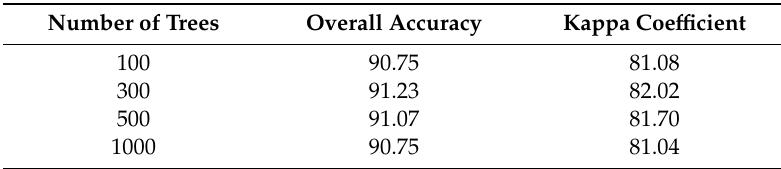
Table 2. Performance of the RF algorithm with di ff erent Number of Trees